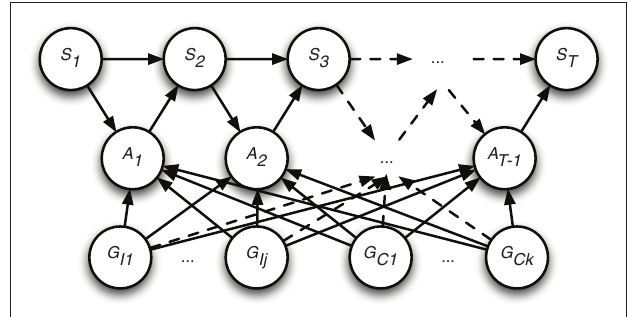
Figure A4 | The Bayesian network showing the dependencies between the variables in the S ender and r eceiver models. Arrows denote dependencies, and all actions ( A ∈ A ) are arbitrarily dependent on one or more (instrumental or communicative) goal variables (